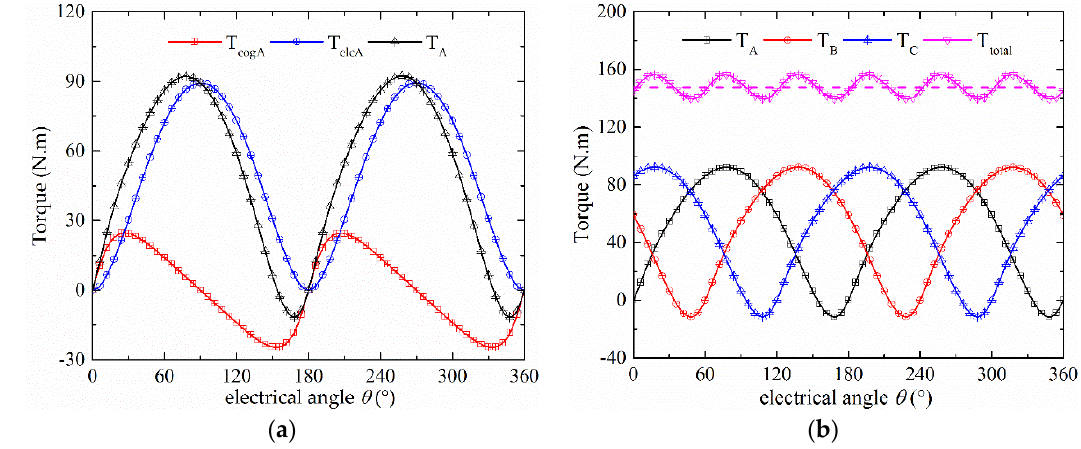
Figure 10. The torque of CS ‐ TFM: ( a ) single ‐ phase torque; and ( b ) total torque.